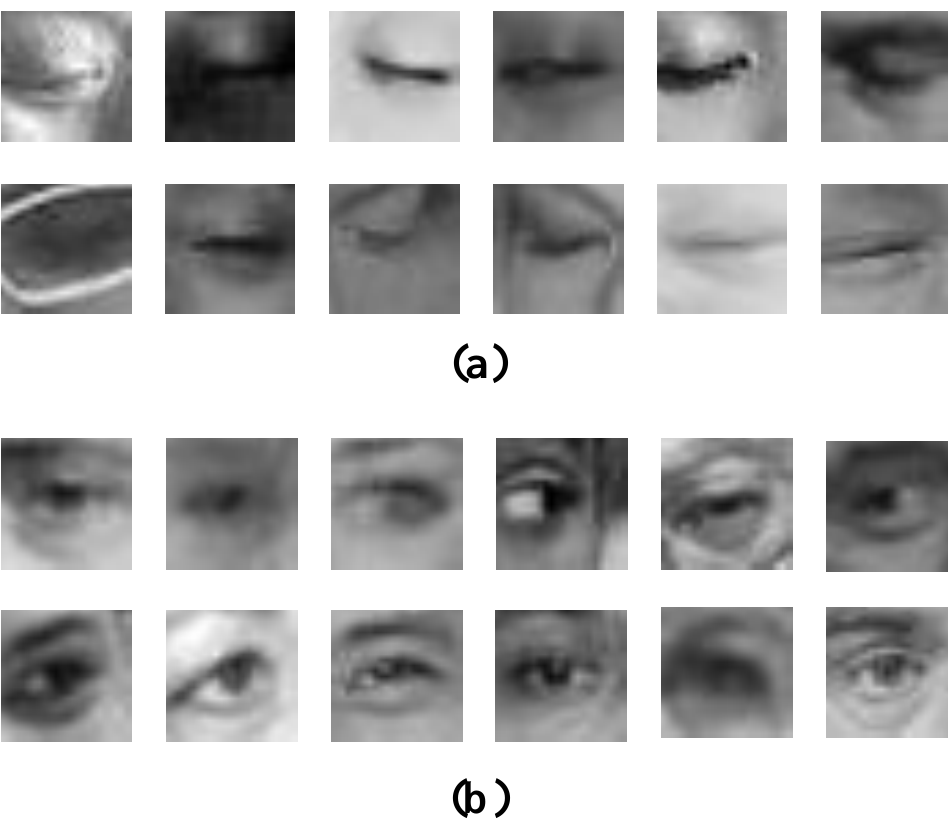
Figure 3. Examples of eye samples used to train the eye state detection convolutional neural network. ( a ) closed eye samples; ( b ) opened eye